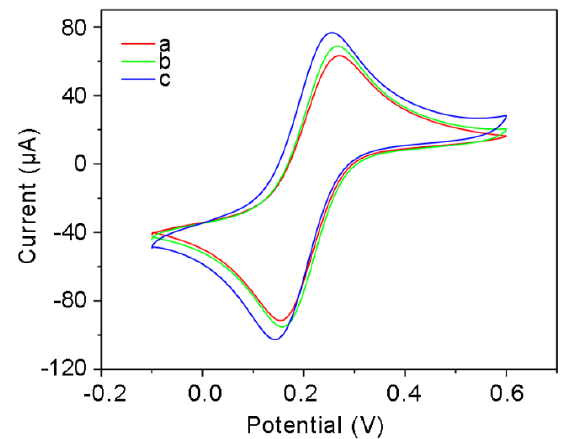
Figure 2. Cyclic voltammetry of nanomaterials. CV profiles of MoS 2 / GCE (a), MoS 2 -Au / GCE (b), MoS 2 -Au-Ag / GCE (c) recorded in K 3 [Fe(CN) 6 ] .